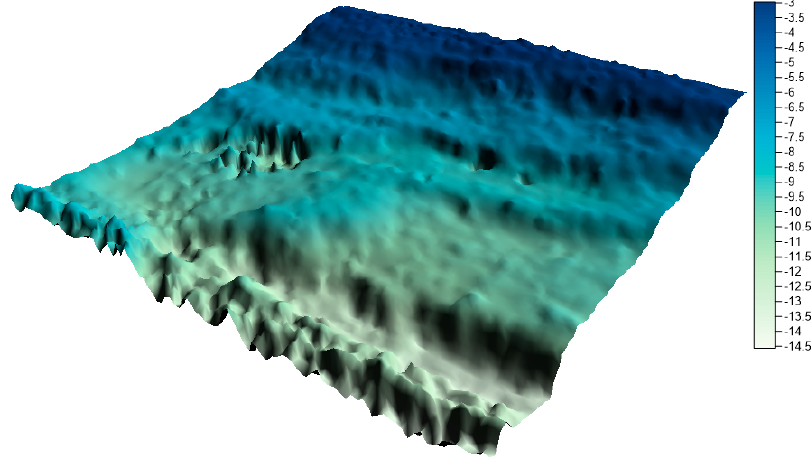
Figure 11. Surface obtained by integrated dataset no. 1 for the LNG port area.